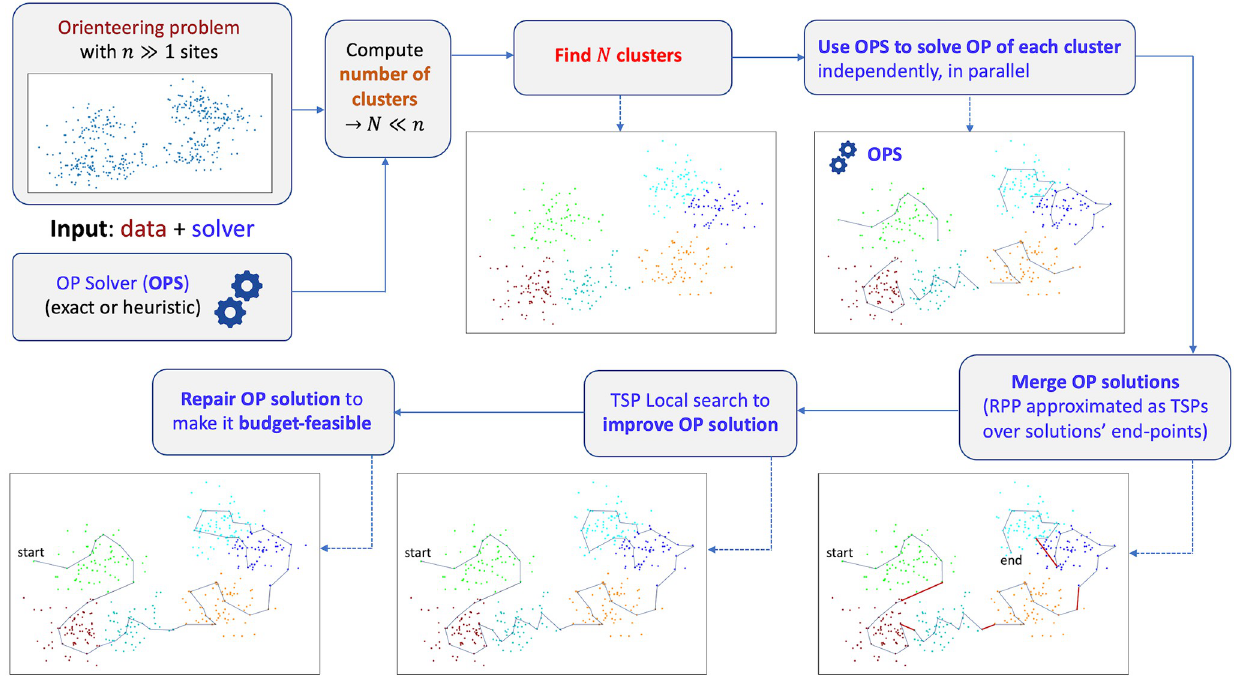
Fig 1. Clustering-based metaheuristic. Illustration of the logical organization and multi-staged workflow of the proposed clustering-based metaheuristic.